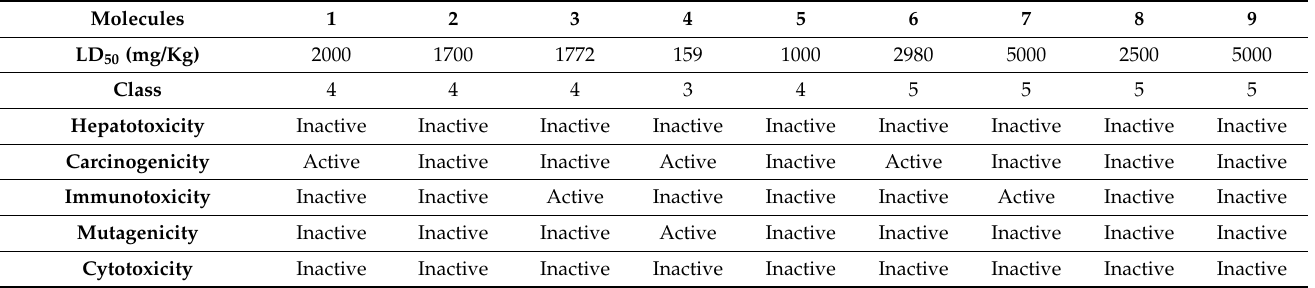
Table 7. Toxicity characteristic prediction for A. halimus leaf ethanolic extract